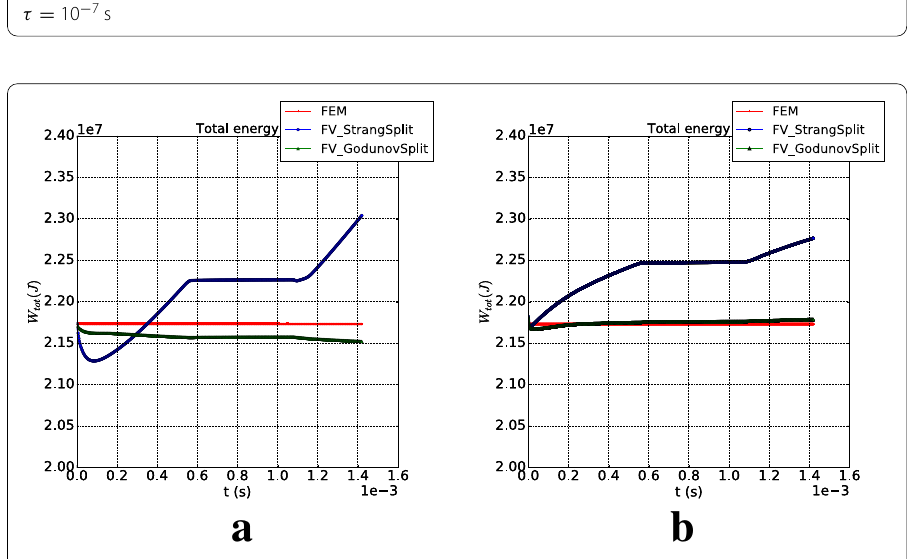
Fig. 7 Time evolution of the total energy shown for different values of the CFL number, computed with a relaxation parameter τ = 1 × 10 − 7 s, with the elastic–viscoplastic finite element (FEM), finite volume (FV) with Strang and Godunov splitting numerical solutions. a CFL = 0 . 4. b CFL = 0 .